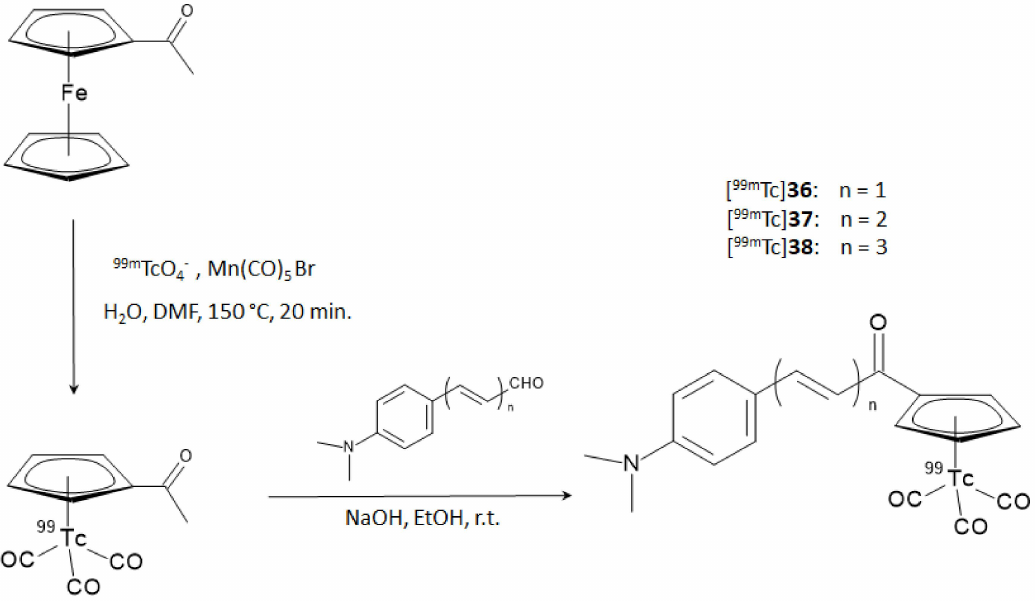
Figure 14. Synthetic steps for the preparation of [Cp 99m Tc(CO) 3 ]-chalcone-mimic derivatives (com- pounds ([ 99m Tc] 36 – 38